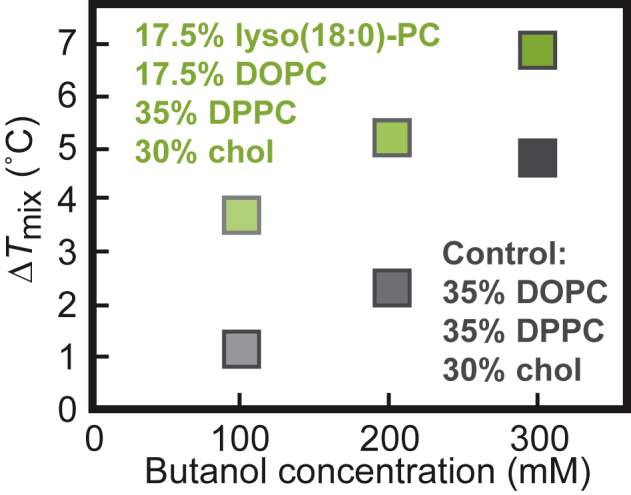
Miscibility transition temperatures of GUVs composed of 17.5/17.5/35/30 lyso(18:0)-PC/DOPC/DPPC/cholesterol (green, top) and composed of 35/35/30 DOPC/DPPC/cholesterol (gray, bottom) increase with the concentration of butanol in solution (increasing darkness of the points). Each point represents a single experiment for which uncertainties are smaller than symbols. ΔTmix is with respect to vesicles with no butanol. To see this figure in color, go online.